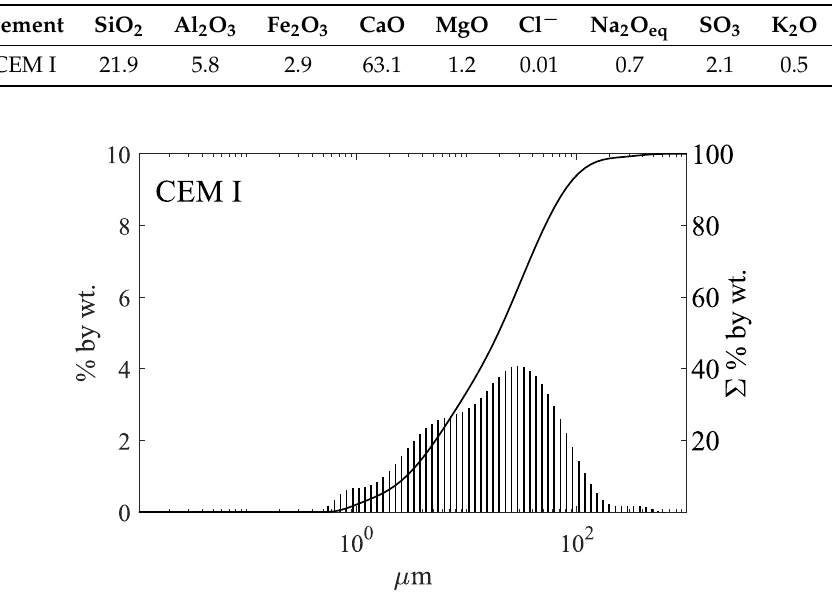
Figure 1. Particle size distribution of Portland cement CEM I 42.5 R (CEM